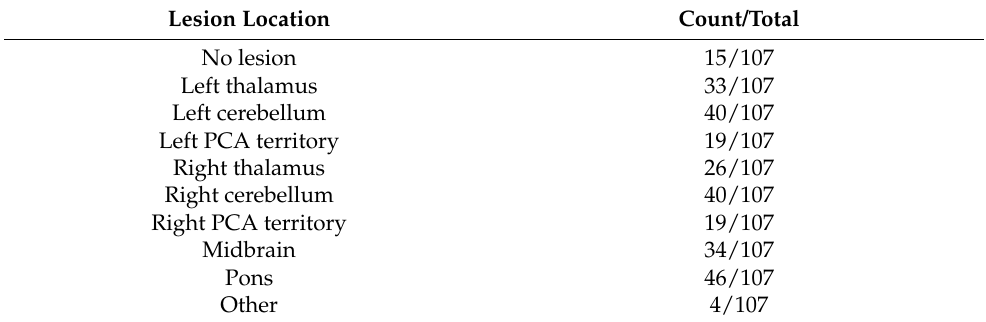
Table A3. The ICC, Dice coefficients, bias, and limits of agreement between the automatically quantified and manually segmented volumes, respectively for the Transfer Learned (TL-CNN), Anterior Circulation Stroke (ACS-CNN), Combined Dataset (CD-CNN), and Posterior Circulation Stroke (PCS-CNN) Convolutional Neural Networks, tested on the PCS test Table A2. Lesion location in the posterior fossa, which was scored manually by using the PC-AS- PECTS.